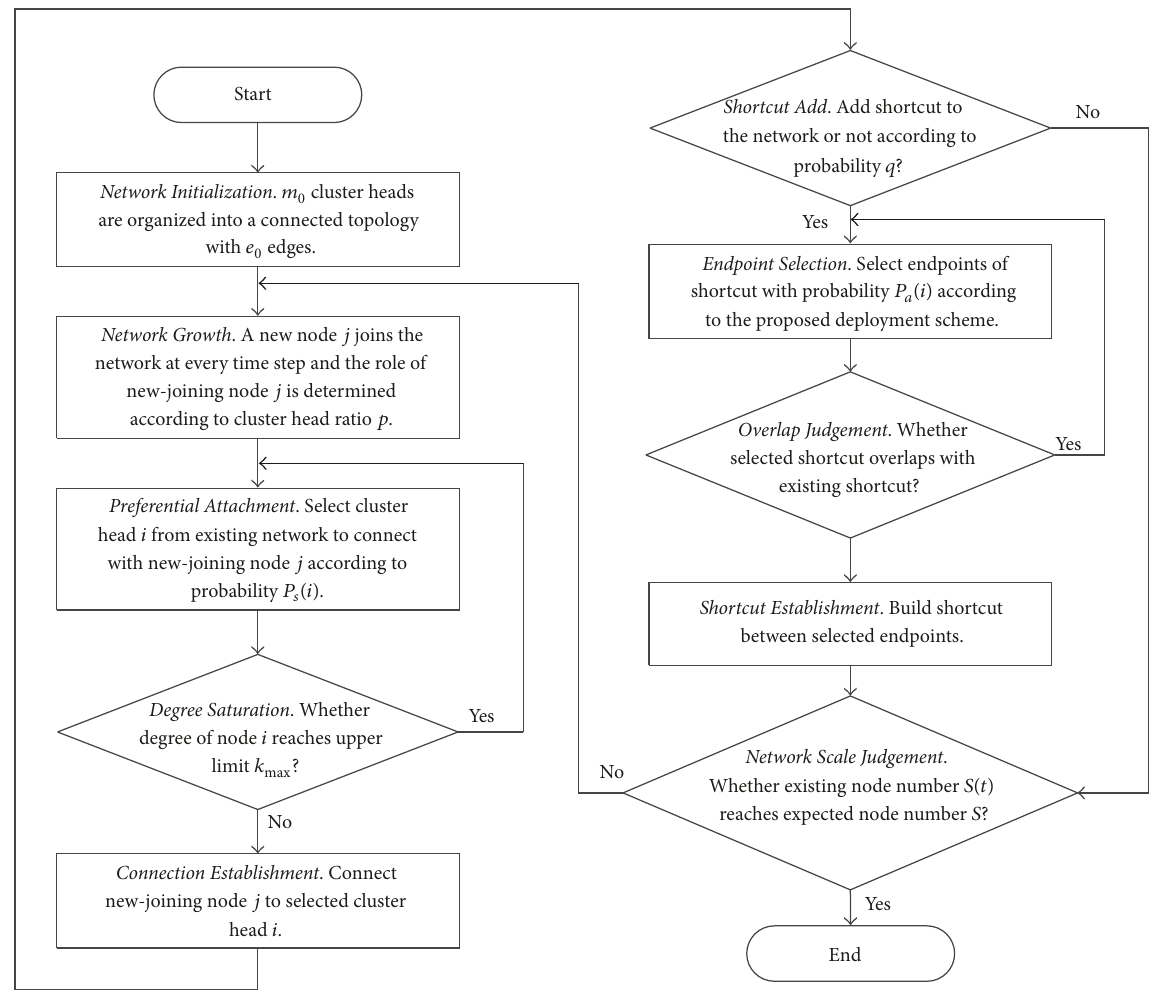
Figure 1: Flow chart of our